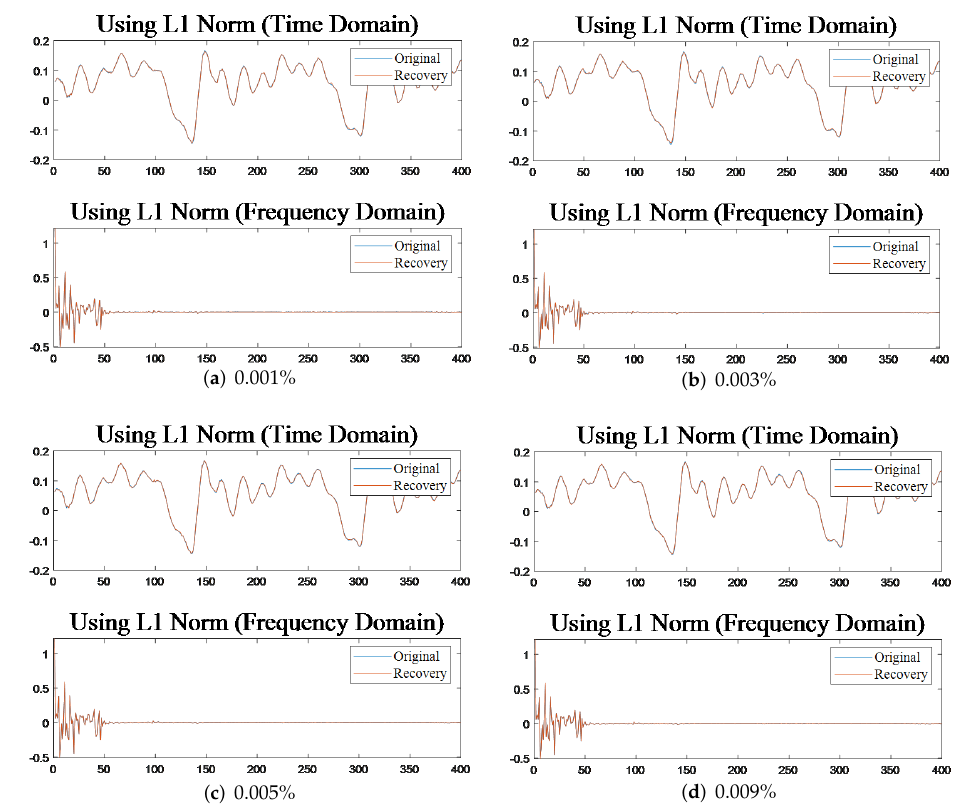
Figure 11. ( a ) When m / n = 0.7, Gaussian noise intensity is 0.001%, the performance of the recovered speech signal in the time domain and frequency domain. ( b ) m / n = 0.7, Gaussian noise intensity is 0.003%, the performance of the recovered speech signal in the time domain and frequency domain. ( c ) m / n = 0.7, the performance of the recovered speech signal in the time domain and frequency domain when the Gaussian noise intensity is 0.005%. ( d ) m / n = 0.7, the performance of the recovered speech signal in the time domain and frequency domain when the Gaussian noise intensity is